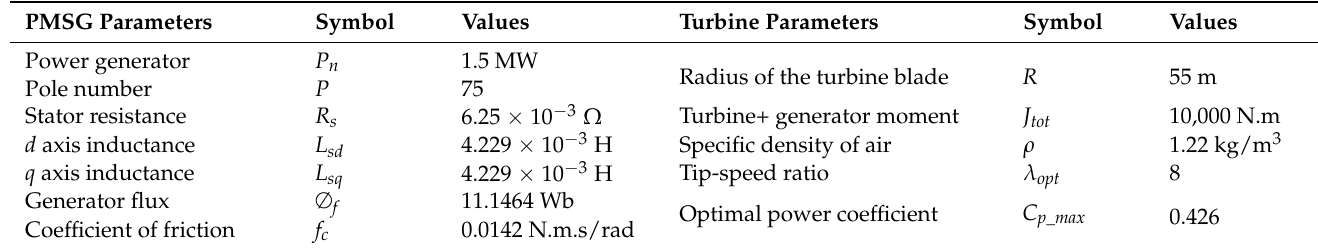
Table A1. PMSG and Wind Turbine